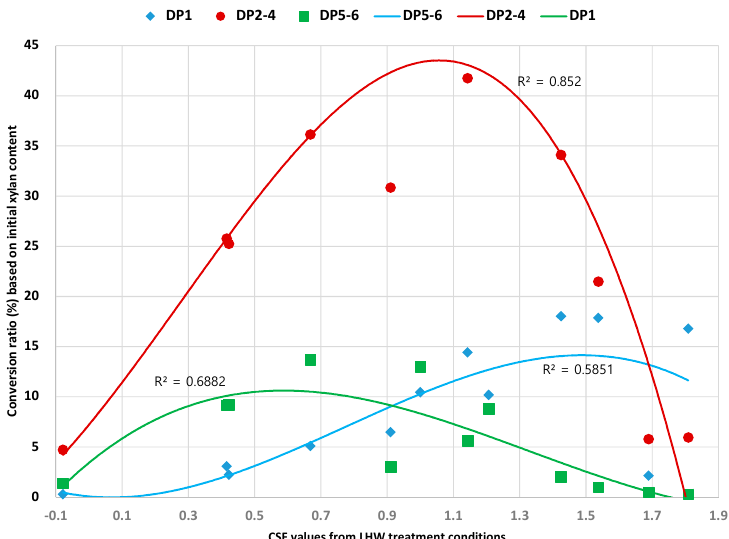
Figure 4. Conversion ratio (%) of xylose and XOS as a DP variation depending on changes of CSF value of LHW treatment conditions.